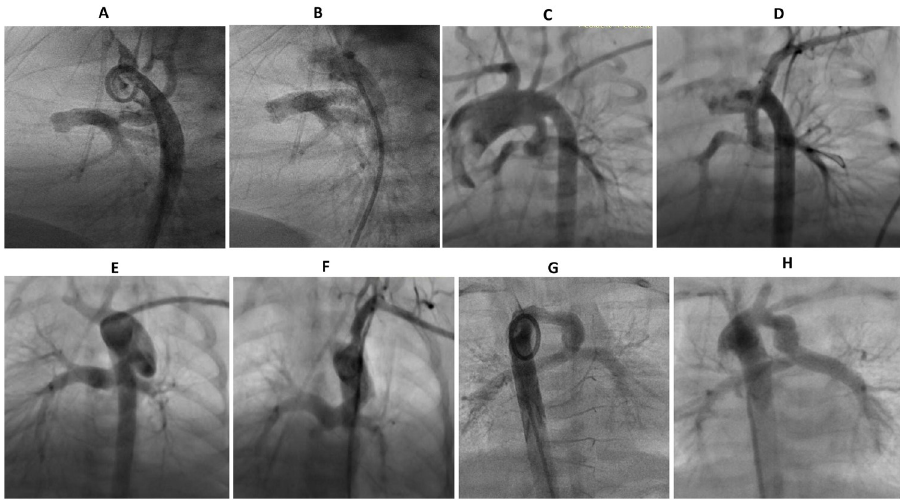
Fig 1. Angiography done during cardiac catheterization showing various PDA origins and morphology before and after ductal stenting. A-B: Group 1 with PDA arises from the proximal descending aorta, C-D: Group 2 with PDA arises from the undersurface of aortic arch, E-F: Group 3 with PDA opposite the left subclavian artery, G-H: Group 4 with PDA opposite the innominate/Brachiocephalic